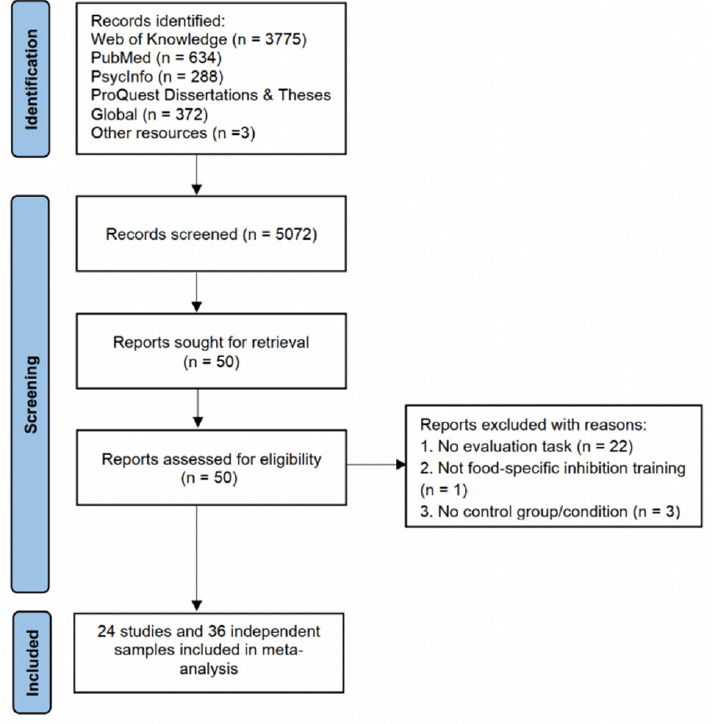
Figure 1. Flow diagram illustrating the process of our review, screening, and article selection pro ‐ cesses.